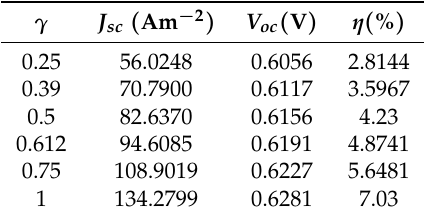
Table 2. Values for J sc , V oc and η for several values of γ at time t = 100